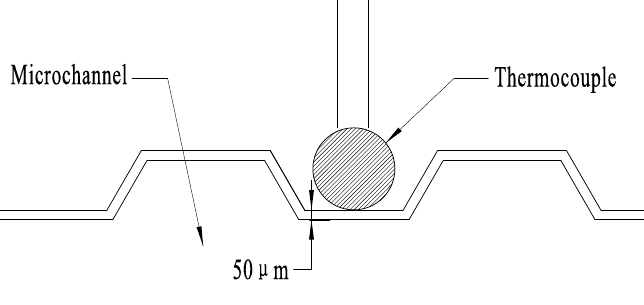
Figure 2. Schematic of the thermocouple relative to the microchannel.